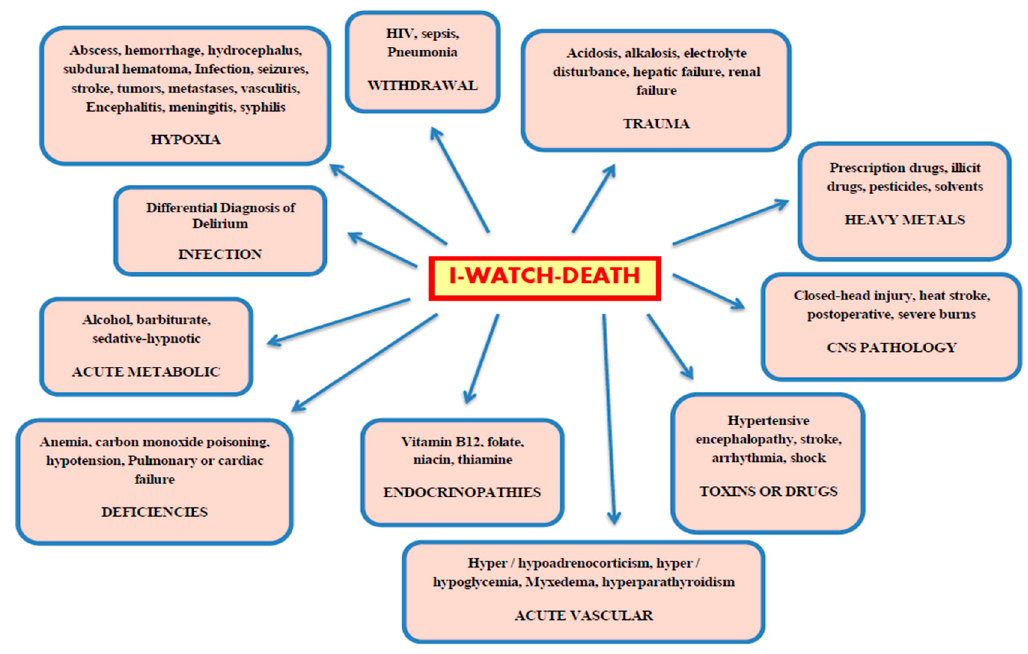
Figure 1. The I-WATCH-DEATH mnemonic [12].